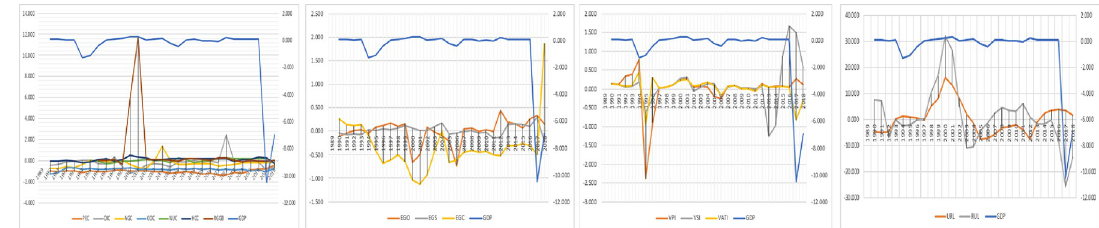
Fig 7. GDP with primary energy consumptions, energy generation, value-added primary industries, and urban and rural